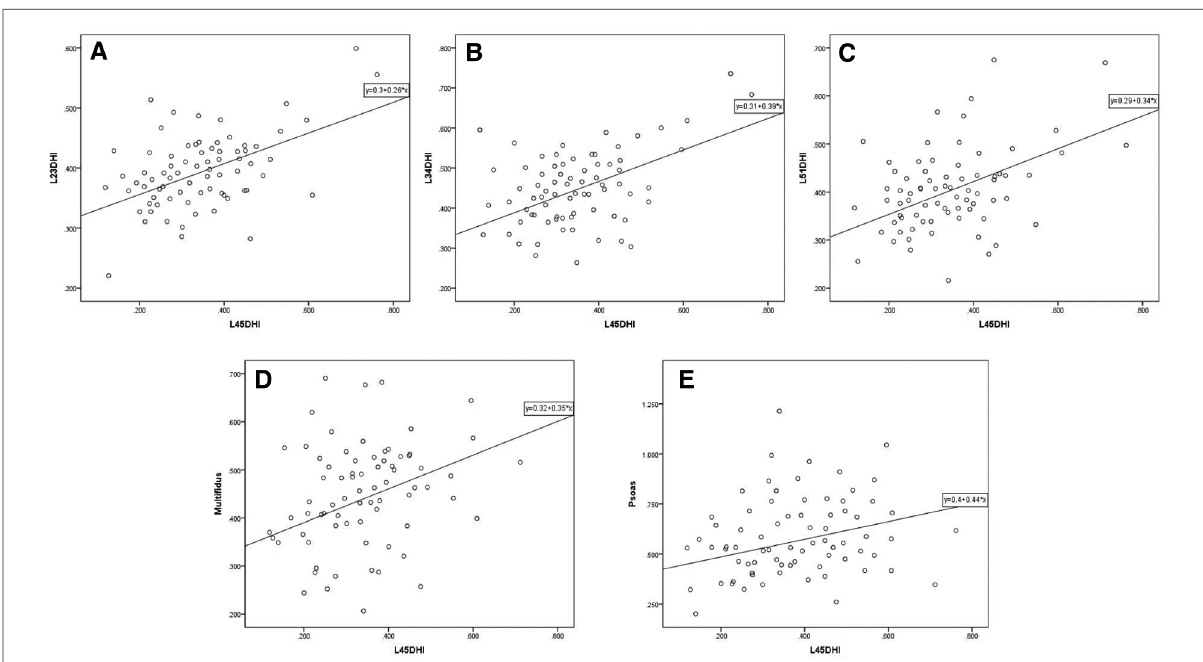
FIGURE 7 Scatter plot of L4/5 DHI and other imaging parameters in DLS group. ( A , B , C ) L4/5 DHI showed signi fi cant positive correlations with L2/3 DHI ( r =0.470, P <0.05), L3/4 DHI ( r =0.529, P <0.05), and L5/S1 DHI ( r =0.463, P <0.05) in the DLS group. ( D , E ) L4/5 DHI showed signi fi cant positive correlations with the RCSA of the multi fi dus muscle ( r =0.390, P <0.05) and psoas major muscle ( r =0.294, P <0.05). DHI: disc height index, Multi fi dus: relative cross-sectional area of multi fi dus muscle, Psoas: relative cross-sectional area of psoas major